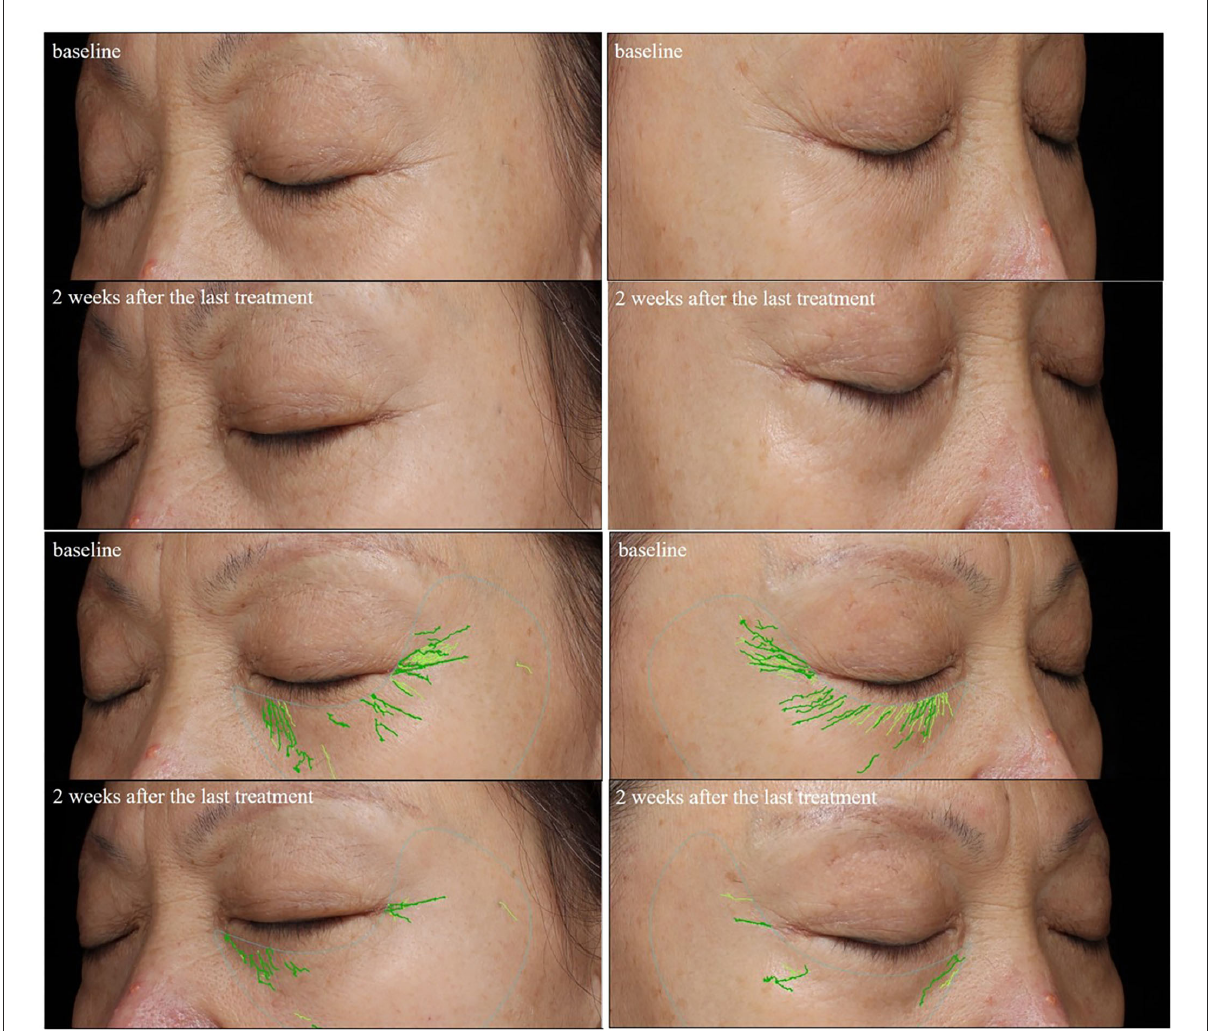
FIGURE4 Comparison of the periorbital wrinkles in a 59-year-old woman with the VISIA images system. Her left periorbital area was treated with ECM-C via MN; the wrinkles score assessed by the VISIA images system decreased from 13.54 to 5.78; her right periorbital area was treated with ECM-C via MN and radiofrequency; the wrinkles score assessed by the VISIA images system decreased from 17.37 to 3.80.